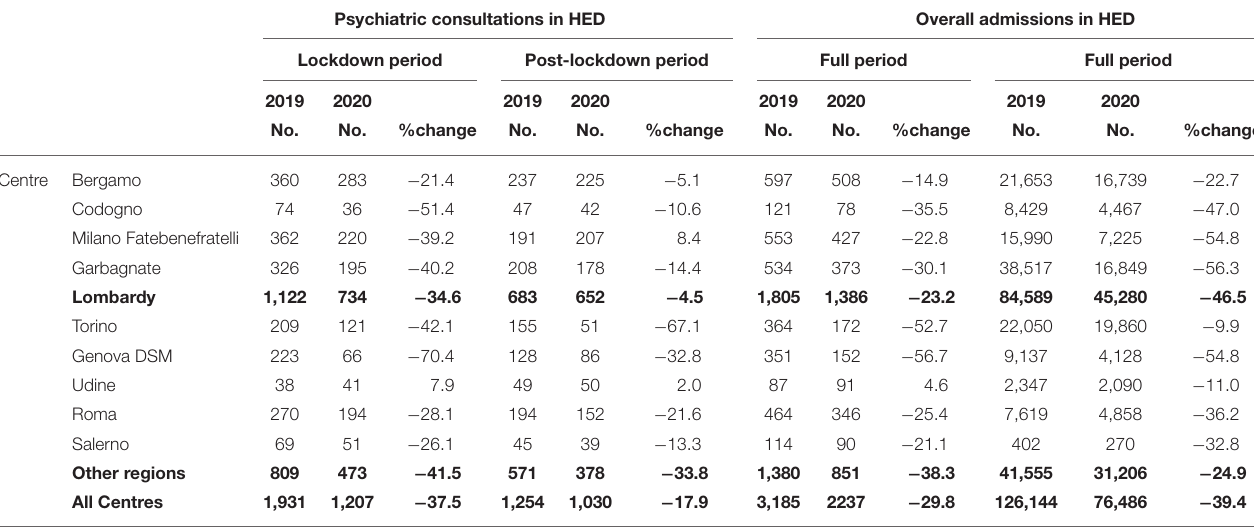
TABLE 2 | Psychiatric and overall consultations by period, year and